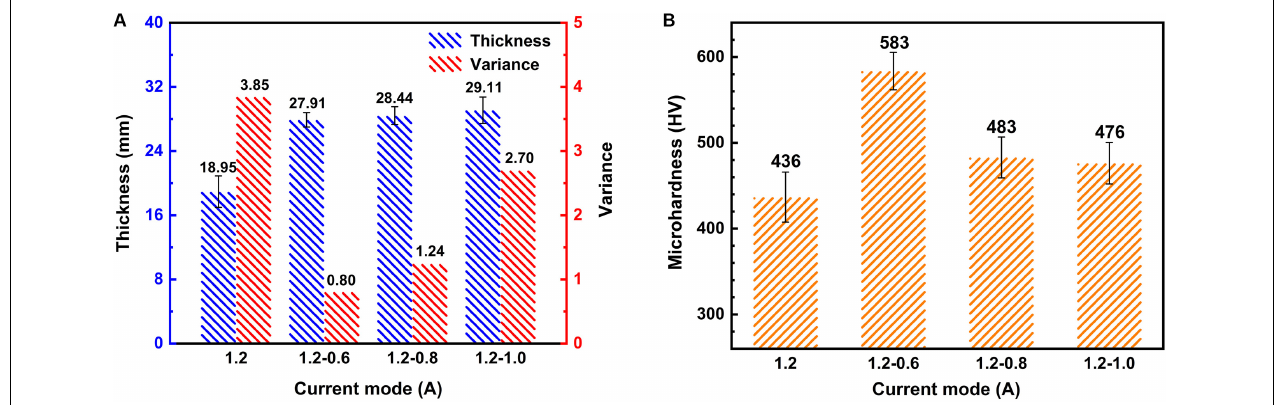
FIGURE 6 | (A) Coating thickness, variance, and (B) corrosion rate under different current modes.